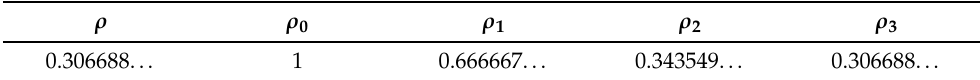
Table 1. Radius for Example 1.